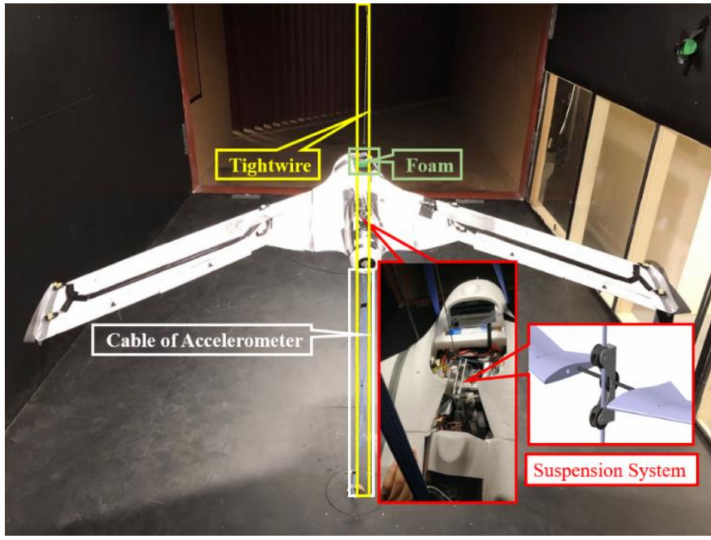
Figure 15. Wind tunnel test arrangement.